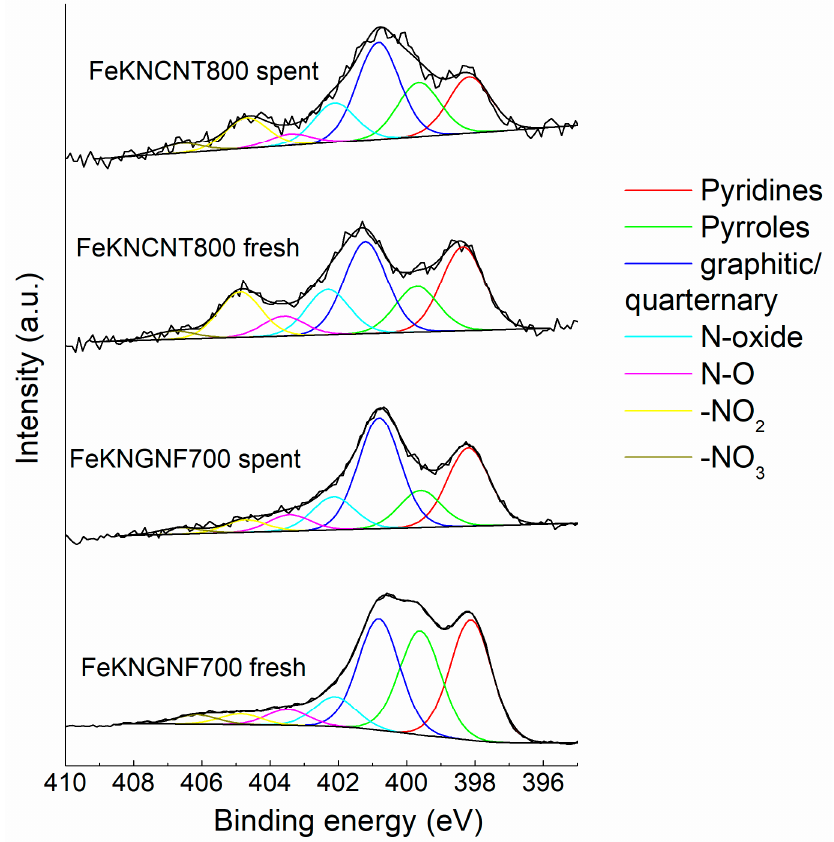
Figure 5. The N1s XPS spectra of fresh and spent catalysts. Components in the spectra were assigned according to Refs. [46–49].